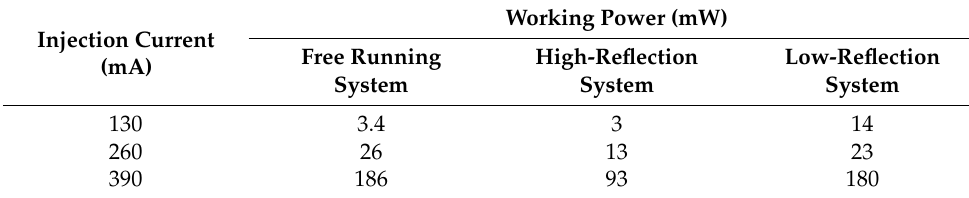
Table 2. The measured output power at low, medium and high injection currents for both high- reflection and low-reflection system configurations as well as the optical power of a free-running LD system [21].